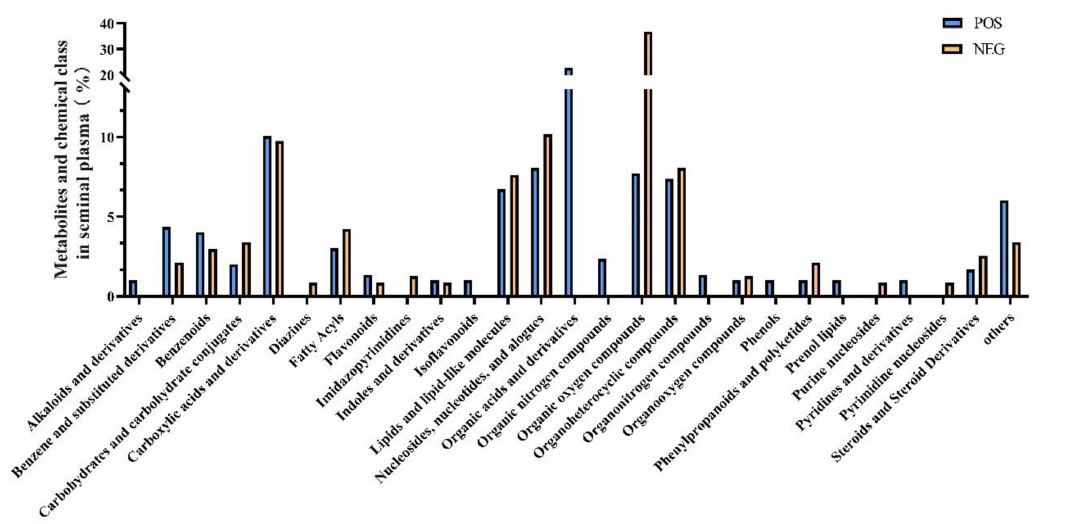
Figure 2. Metabolites and chemical class of seminal